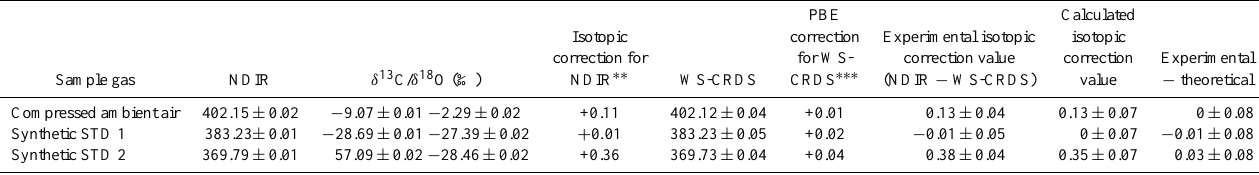
Table 2. Comparison of experimental and theoretical isotopic correction values ∗ . PBE Calculated Isotopic correction Experimental isotopic isotopic correction for for WS- correction value correction Experimental Sample gas NDIR δ 13 C/ δ 18 O (‰) NDIR ∗∗ WS-CRDS CRDS ∗∗∗ (NDIR − WS-CRDS) value − theoretical Compressed ambient air 402.15 ± 0.02